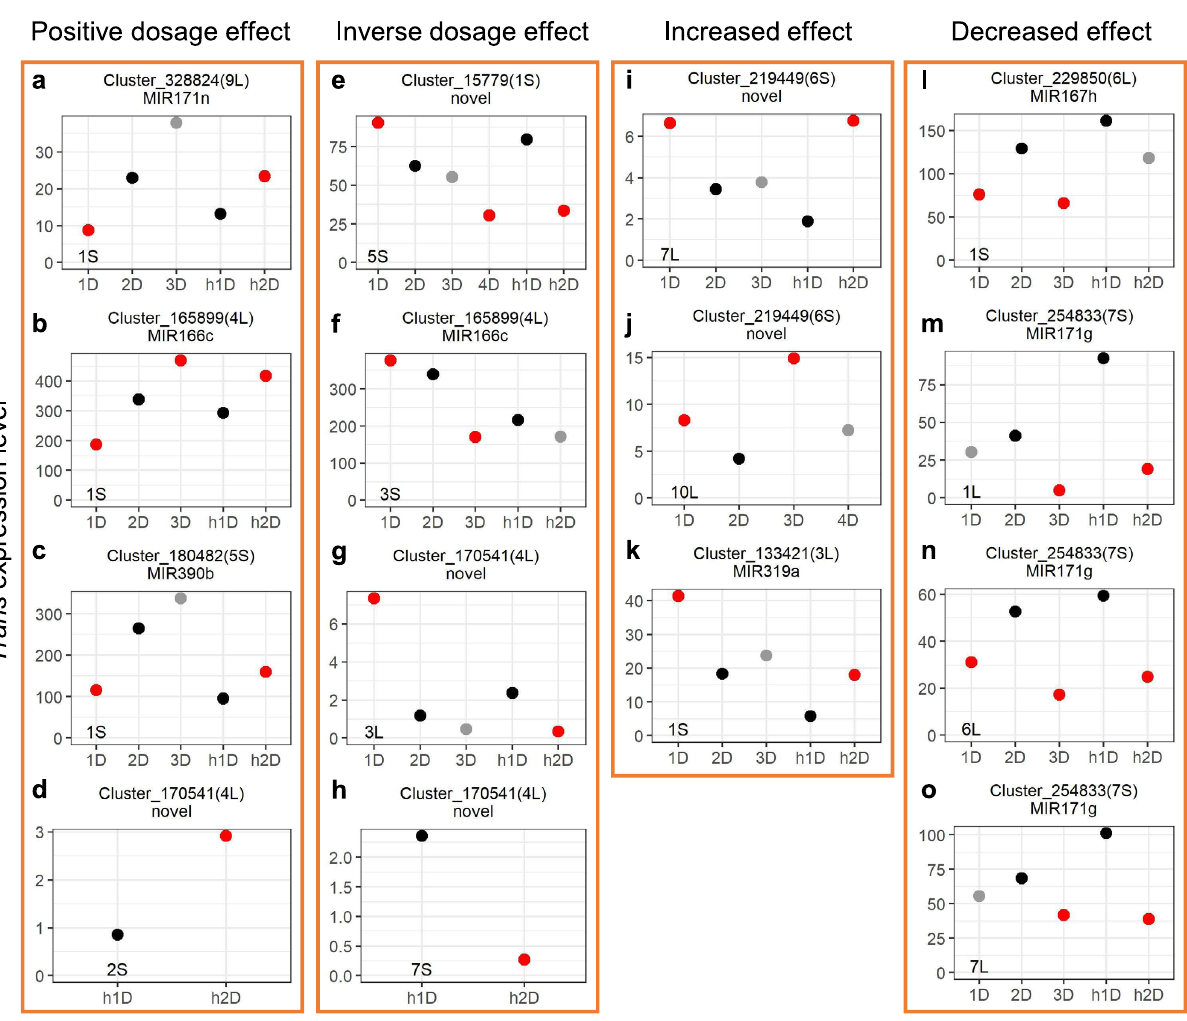
Fig. 9 Expression patterns of trans DEMs. The cis location of each MIRNA is depicted within parentheses. The x-axis refers to the dosage of the chromosomal region as noted in the bottom-left corner of each panel, whereas the y-axis designates the expression level (rpm) of each MIRNA corresponding to the genotype on the x-axis. Thus, all MIRNAs are in trans , with altered expression levels and unvaried DNA copy numbers. Other aspects were computed as in Fig. 8. a – d Example MIRNAs showing a positive modulation. e – h Example MIRNAs showing an inverse dosage effect. i – k Example MIRNAs exhibiting an increased effect. l – o Example MIRNAs exhibiting a decreased effect. Source data are provided in Supplementary Data